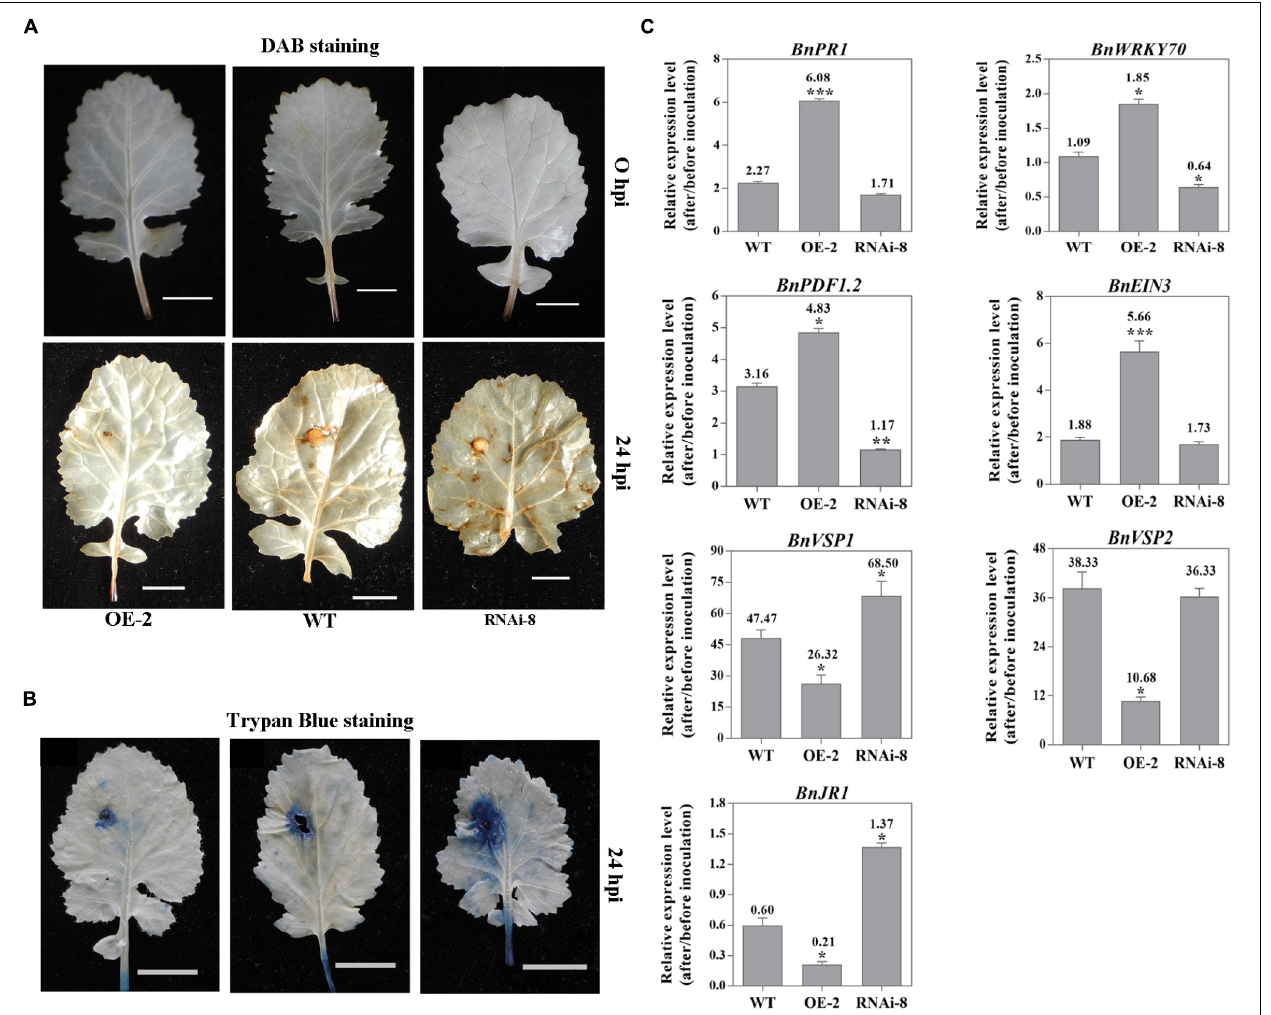
FIGURE 5 | Altered expression of BnaMPK3 affects S. sclerotiorum -induced defense response in BnaMPK3 -OE and BnaMPK3 -RNAi plants. (A) H 2 O 2 accumulation in inoculated leaves. In situ detection of H 2 O 2 was performed using 3,3-diaminobenzidine staining in the BnaMPK3- overexpressing transgenic line 2 (OE-2), the untransformed wild-type (WT) control and the BnaMPK3- RNA-interfering transgenic line 8 at 0 and 24 h post-inoculation with S. sclerotiorum (hpi). (B) Plant cell death was examined by using trypan blue staining on leaves of the line OE-2, WT control and the line RNAi-8. (C) Changes in expression of defense genes associated with SA, JA, and ET defense signaling in OE-2, WT, and RNAi-8 plants after 24 hpi. Samples were collected at the indicated time for total RNAs isolation. Expressions of these genes were quantified by real-time PCR, and then change of gene expression (folds of change relative to the level before inoculation) was calculated. Values are means of three replicates, and error bars indicate standard deviations. The significances of the gene expression differences between each transgenic line and WT are indicated (Student’s t -test, ∗∗∗ P < 0.001, ∗∗ 0.001 < P < 0.01 or ∗ 0.01 < P < 0.05). These above experiments were repeated with the BnaMPK3- overexpressing lines 6 and 8, and the BnaMPK3 -RNAi lines 16 and 19, respectively, and results are